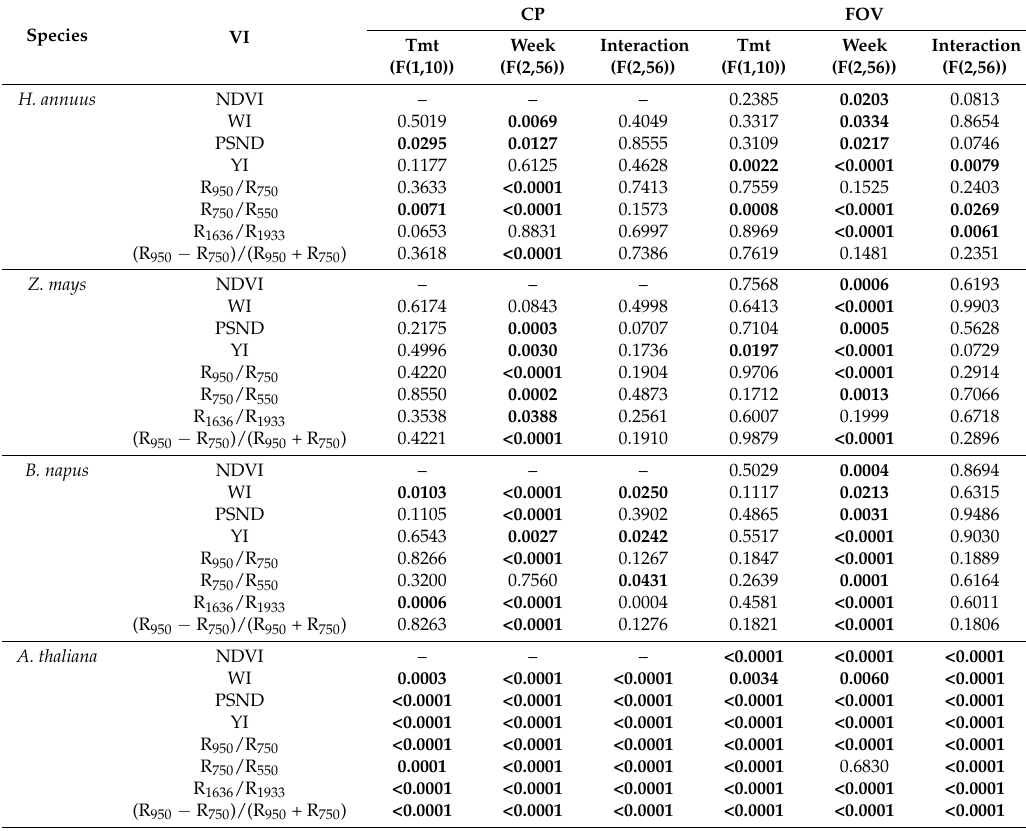
Table A3. Results of initial mixed-effects analysis of VI. Significant p -values shown in bold.